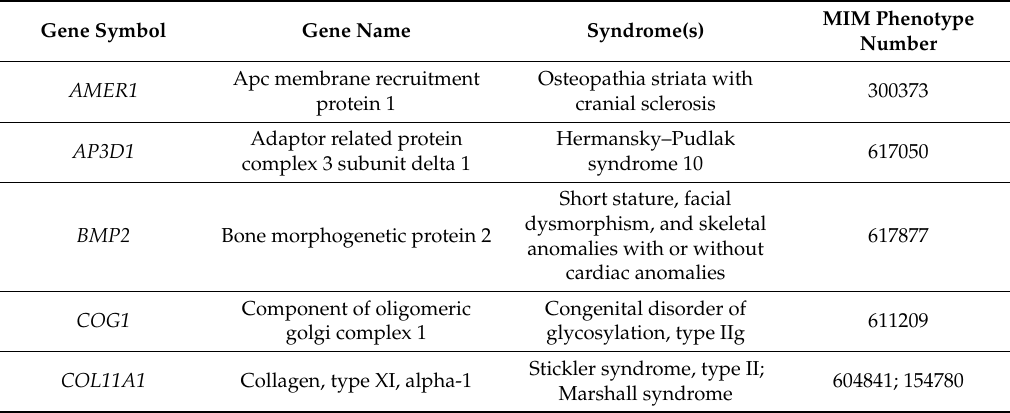
Table 1. Select genes associated with human PR